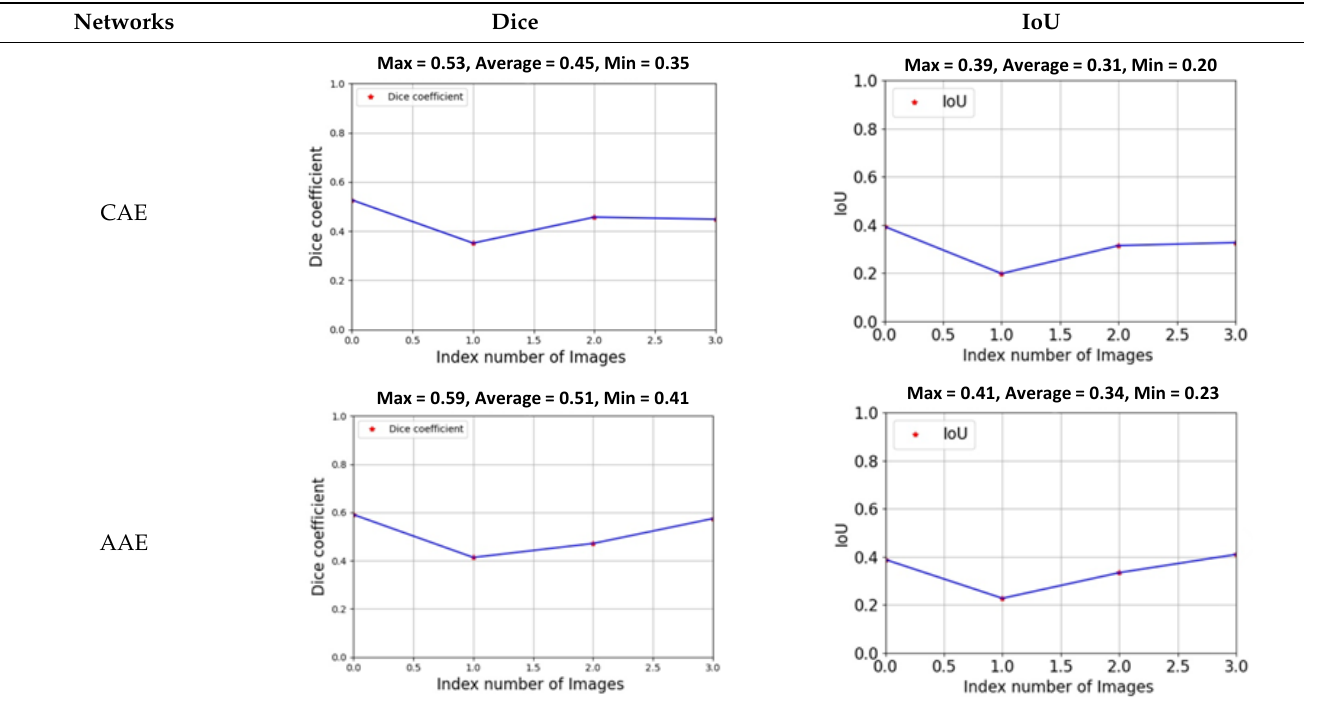
Table 3. The experiment results of AAE and CAE networks.